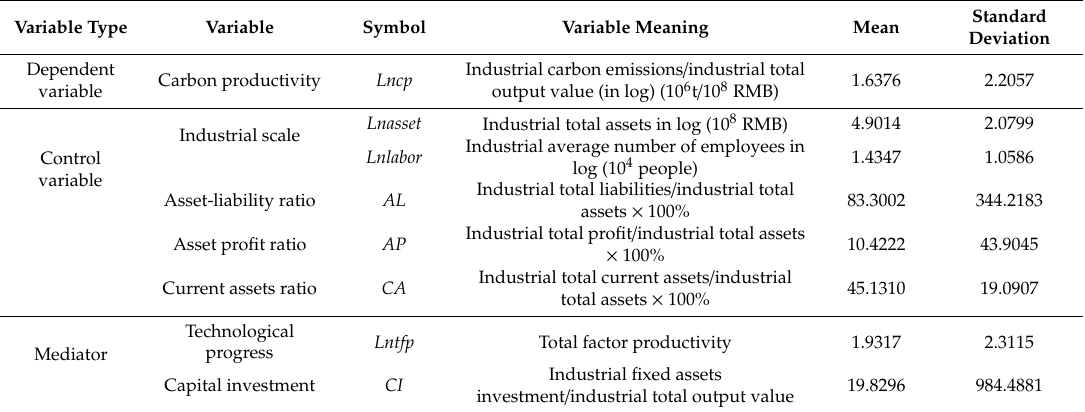
Table 2. Summary statistics.